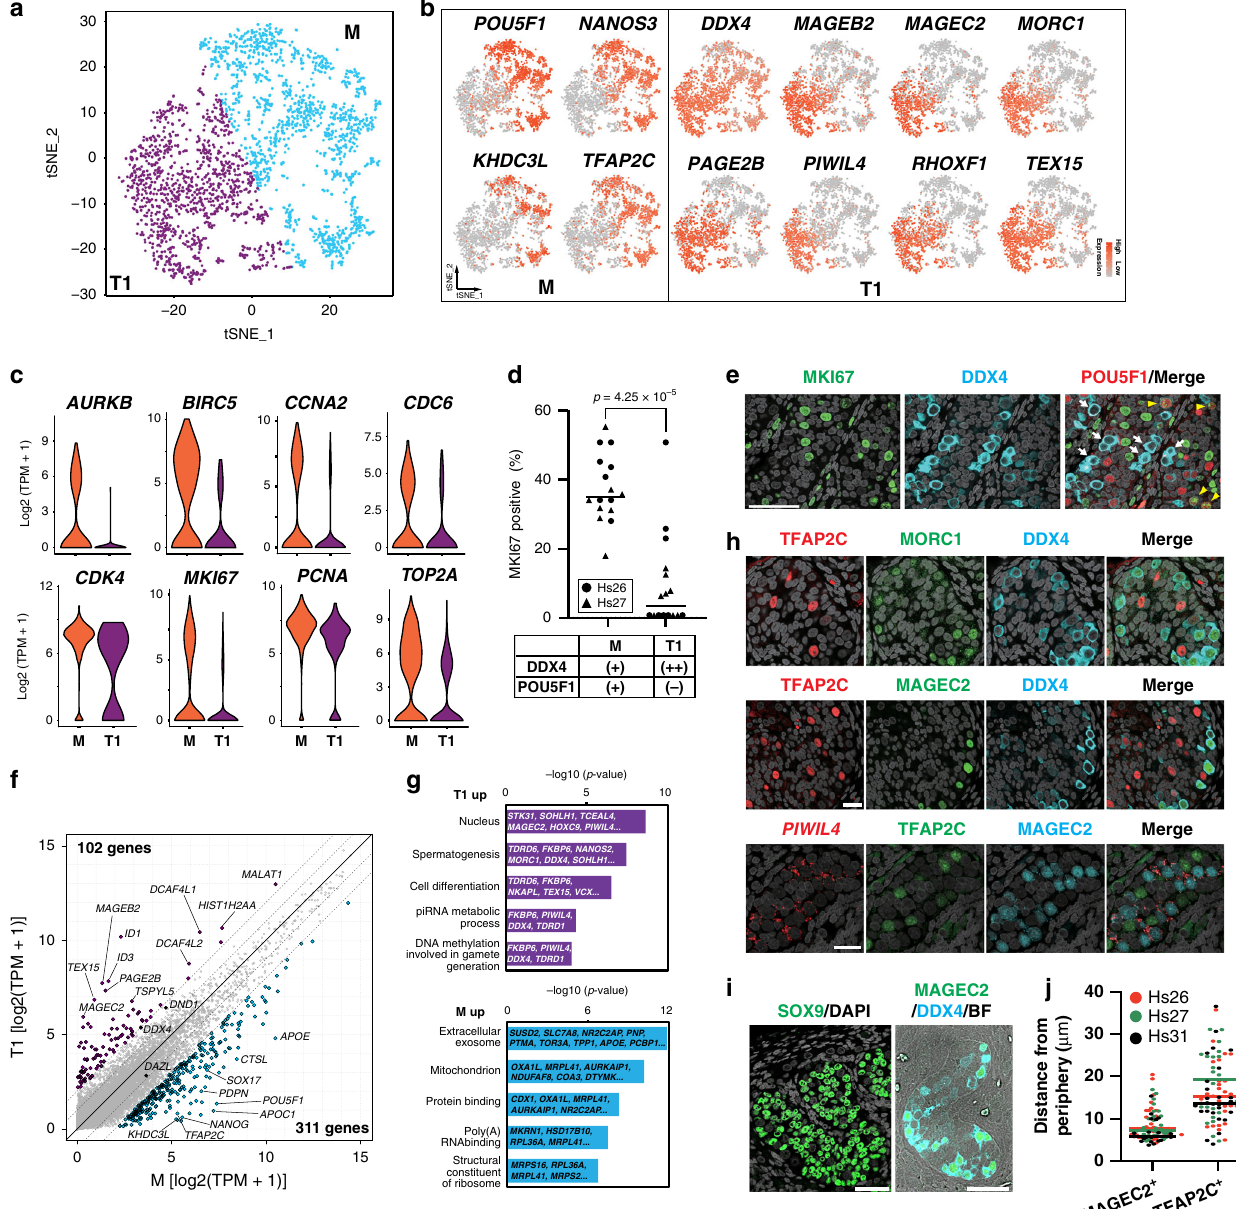
Fig. 1 Characterization of germ cells in human fetal testis during the second trimester. a tSNE plot of germ cells (GCs) de fi ned in Supplementary Fig. 1c. Cluster identities were determined by projecting the expression of marker genes onto the same tSNE plot in ( b ). M, M-prospermatogonia (cyan); T1, T1- prospermatogonia (purple). b tSNE feature plots of known and newly identi fi ed markers for M and T1. c Violin plots of proliferation markers for M (1,419 cells) or T1 (1170 cells) de fi ned in ( a ) and ( b ). FDR<10 − 65 for all markers. d Percentages of MKI67 + cells among DDX4 + POU5F1 + M or DDX4 ++ POU5F1 − T1 present in Hs26 (18w0d, black circle) or Hs27 (18w5d, black triangle) samples as assessed by immuno fl uorescence (IF) analysis. Each dot represents the count per tubular cross section (8 cross sections per sample). P -values for the comparison is determined by two-sided Fisher ’ s exact test ( p = 4.25× 10 − 5 ). e IF images of a paraf fi n section of fetal testis (Hs27) targeted for MKI67 (green) and DDX4 (cyan), merged with DAPI (white) and/or POU5F1(red). White arrows indicate DDX4 ++ POU5F1 − T1 and yellow arrowheads indicate DDX4 + POU5F1 + M co-expressing MKI67. Scale bar, 50 μ m. f Scatter plot comparing averaged gene expression levels between M and T1 (top). Cyan, genes higher in M; purple, genes higher in T1 (more than fourfold difference [ fl anking diagonal lines], mean log2[TPM + 1]>2, FDR<0.01). Key genes are annotated and the number of DEGs are indicated. g Gene Ontology (GO) analysis of the DEGs de fi ned in (f). P -value (one-sided Fisher-exact test) and representative genes assigned to each GO term are shown. h IF images of paraf fi n sections of Hs31 for TFAP2C (red) and DDX4 (cyan) combined with MORC1 (green, top) or MAGEC2 (green, middle), and images for combined in situ hybridization (co-ISH) for PIWIL4 (red) with IF for TFAP2C (green) and MAGEC2 (cyan) (bottom). All images are merged with DAPI (white). Merged images for all four color channels are shown at far right. Scale bars, 25 μ m. i IF images of paraf fi n sections of Hs26 for SOX9 (green) merged with DAPI (left) or for MAGEC2 (green) and DDX4 (cyan) merged with bright fi eld (BF) (right). IF for SOX9 and BF highlight the border between tubules and the stroma. Scale bars, 50 μ m. j Distances ( μ m) from the periphery of tubules for TFAP2C + MAGEC2 − M or TFAP2C − MAGEC2 + T1 as quanti fi ed by IF images for Hs26 (red), Hs27 (green), and Hs31 (purple). Bars indicate the median value for each cell type per sample. n = 78 (Hs26, 28 cells; Hs27, 30 cells; HS31, 20 cells) and 75 (Hs26, 27 cells; HS27, 22 cells; HS31, 26 cells) for TFAP2C − MAGEC2 + T1 and TFAP2C + MAGEC2 − M, respectively. See also Supplementary Fig. 1 and Supplementary Dataset